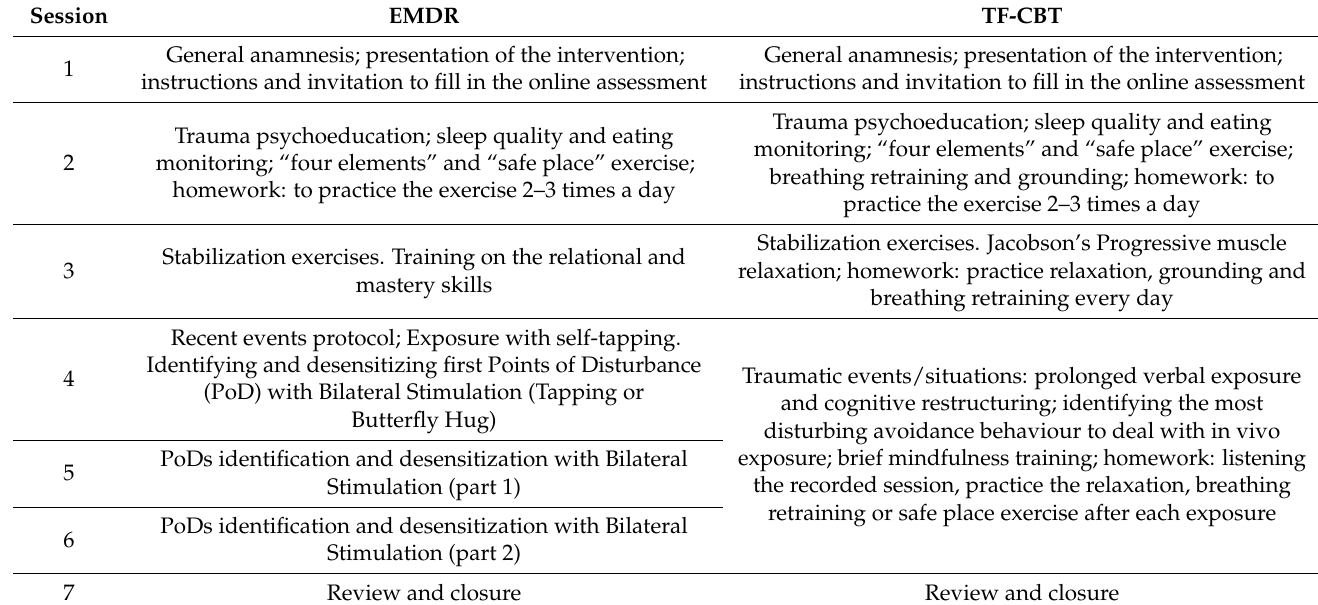
Table 1. Eye movement desensitization and reprocessing (EMDR) and trauma-focused cognitive-behavioural therapy (TF-CBT) protocols: activities planned in each of the 7